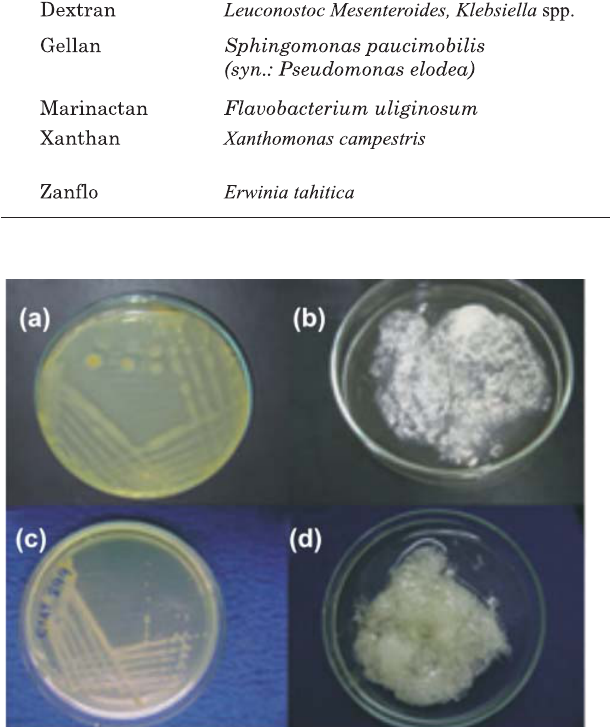
Figure 3. (a) Colonies of the M. plurifarium BR3804 strain, grown in 79 medium with bromothymol blue; (b) the biopolymer produced by